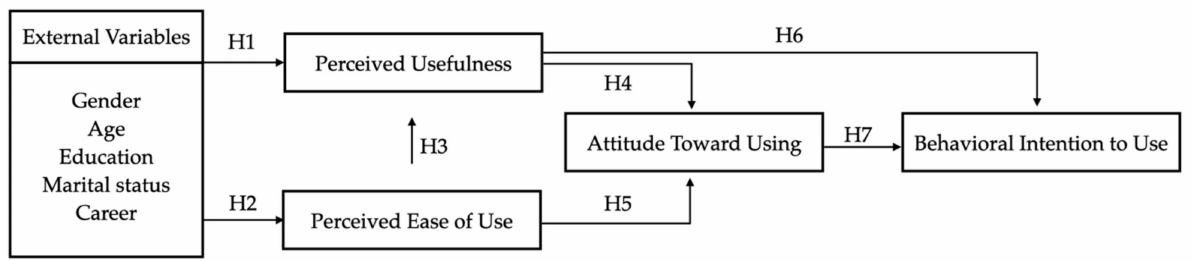
Figure 5. Structure of the research